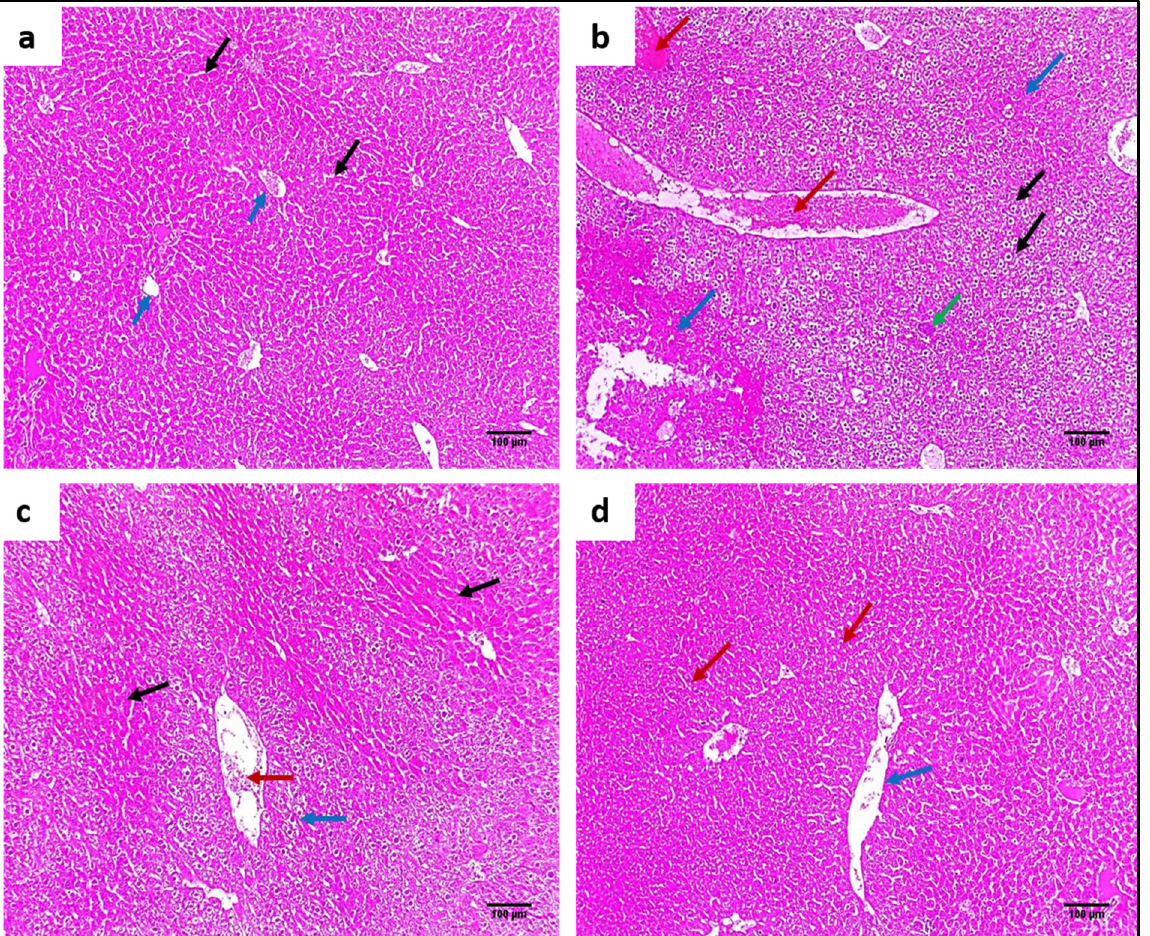
Figure 8. H&E micrographs of liver sections of ( a ) normal liver showing average-sized central veins (blue arrows) bounded by cords of hepatocytes separated by blood sinusoids (black arrows) (×100). ( b ) Group I showed congested vessels (red arrows) bounded by hepatocytes with hydropic degeneration (black arrows), apoptotic bodies (green arrow), and areas of necrosis (blue arrows) (×100). ( c ) Group II showed mild dilated-sized central veins (red arrow) bounded by cords of hepatocytes with hydropic degeneration (blue arrow), peripheral normal hepatocytes (black arrows), and no necrosis could be detected (×100). ( d ) Group III showed a mild dilated-sized central vein (blue arrow) surrounded by cords of average-sized hepatocytes (red arrows) (×100).